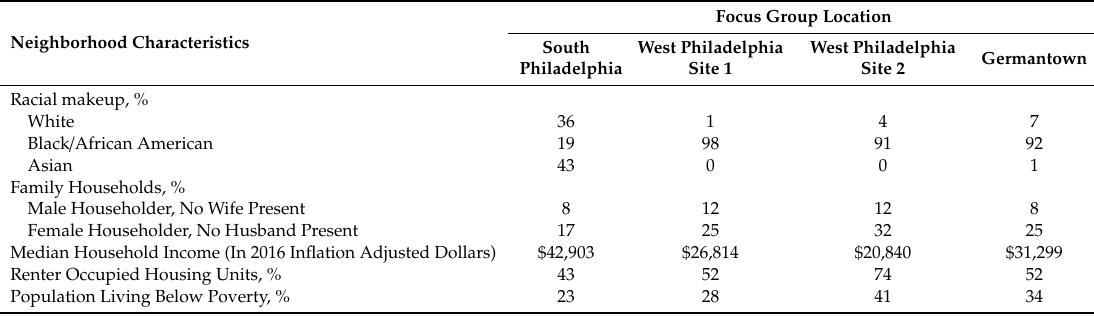
Table 2. Neighborhood characteristics at each focus group location.